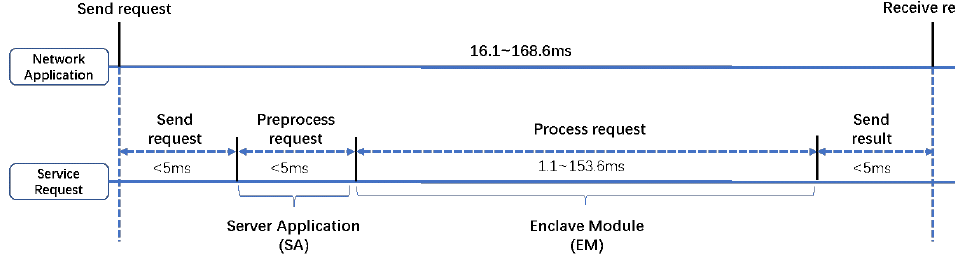
Figure 4. Overhead Imposed by BioShare in Processing a Service Request with Authorized Mode.